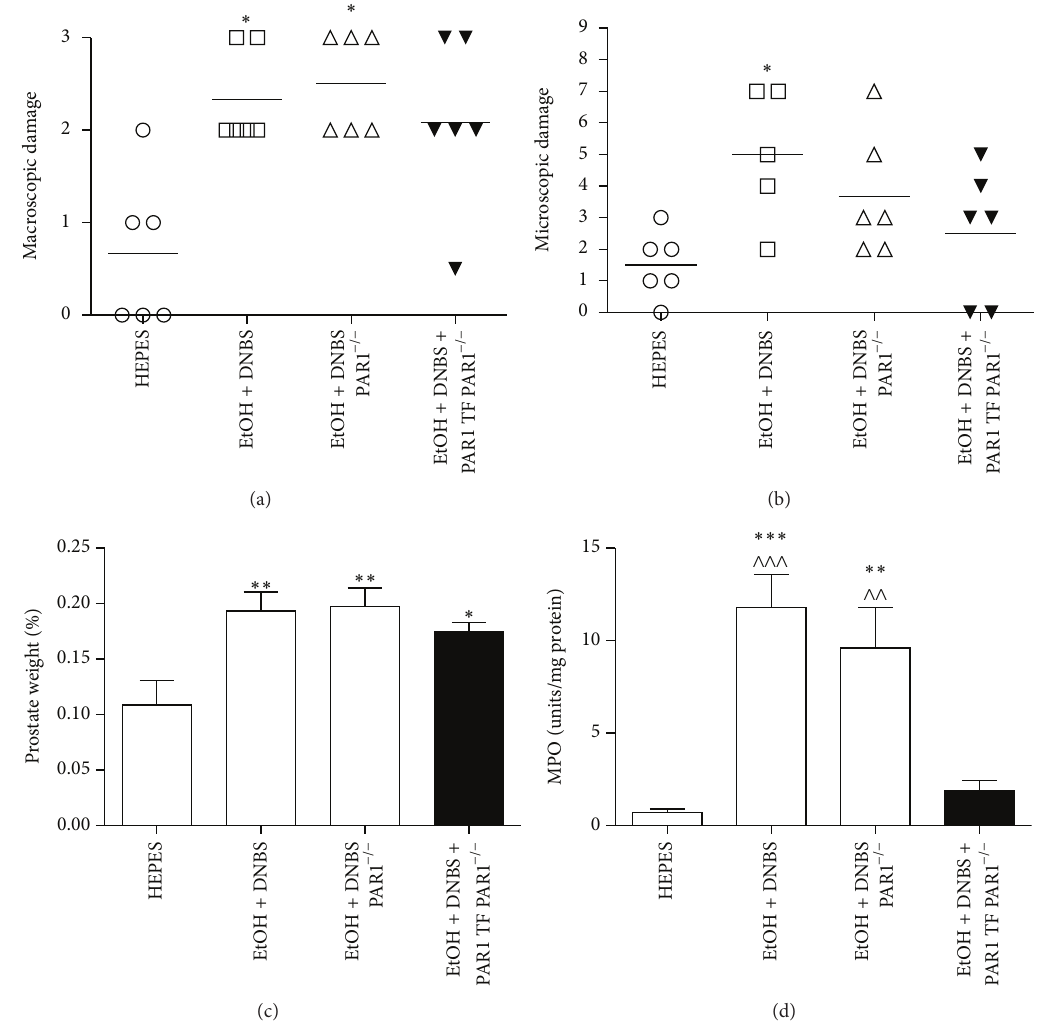
Figure 8: Administration of the PAR1 activating peptide TFLLR-NH 2 elicits non-PAR1-mediated effects in the mouse prostate. Prostates were treated with HEPES vehicle in wild-type mice (HEPES), ethanol + dinitrobenzene sulfonic acid in wild-type mice (EtOH + DNBS), ethanol + dinitrobenzene sulfonic acid in PAR1 knockout mice (EtOH + DNBS PAR1 −/− ), or ethanol + dinitrobenzene sulfonic acid + PAR1 activating peptide TFLLR-NH 2 in PAR1 knockout mice (EtOH + DNBS + PAR1 TF PAR1 −/− ) for 2 days. The inflammatory response was measured by monitoring (a) macroscopic prostate damage, (b) microscopic prostate damage, (c) percent prostate weight, and (d) myeloperoxidase (MPO) activity. Data are mean ± SEM of 𝑛 = 5-6 per group. ∗ 𝑃 < 0.05 , ∗∗ 𝑃 < 0.01 , and ∗∗∗ 𝑃 < 0.001 for treatment groups versus HEPES; ∧∧ 𝑃 < 0.01 , ∧∧∧ 𝑃 < 0.001 for treatment groups versus EtOH + DNBS + PAR-1 TF PAR1 −/−